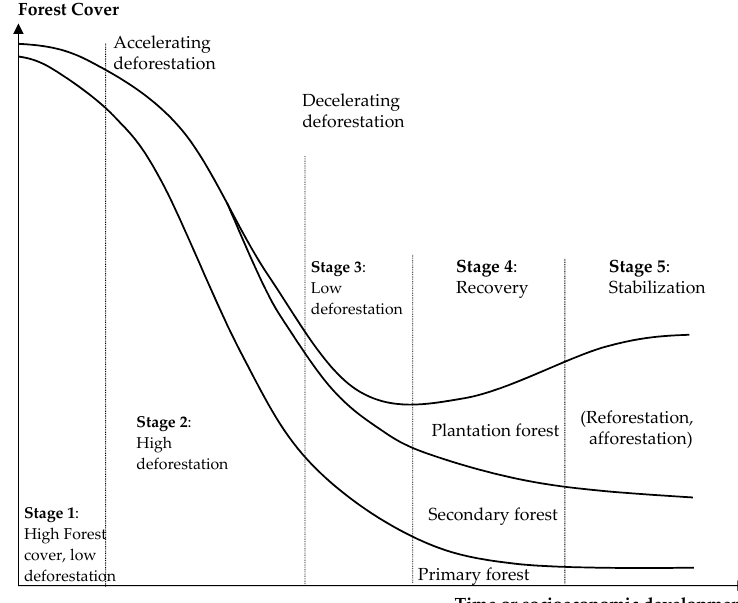
Figure 1. Stages of forest transition curves. Source: adapted from Inoue [35] and Angelsen [7].